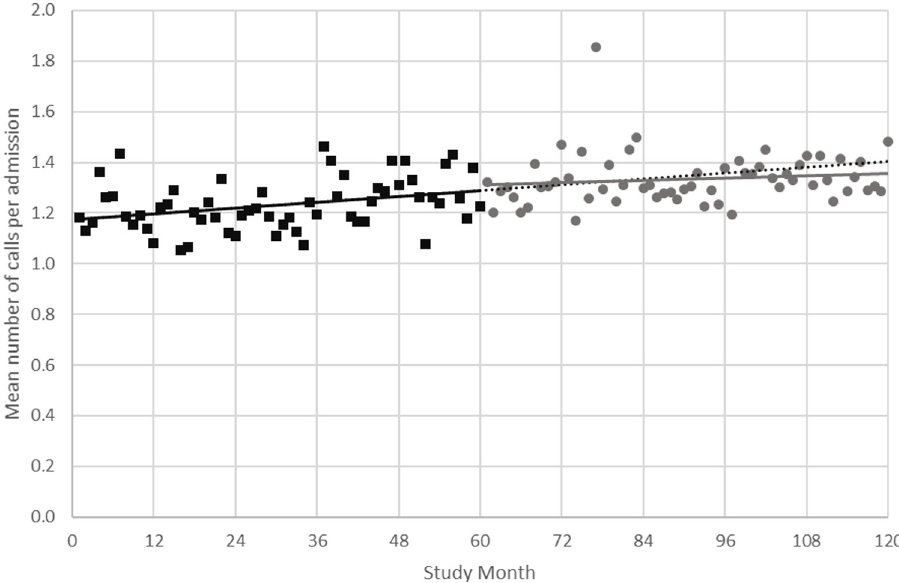
Fig 3. Mean number of calls per admission by study month for the ARIMA univariate model. Phase 1 observed data in black squares, with slope illustrated by the solid black line. Phase 2 observed data in grey circles, with slope illustrated by the solid grey line. The Phase 1 slope is extended into Phase 2 and represented by the dotted black line for comparison with Phase 2 observed data.